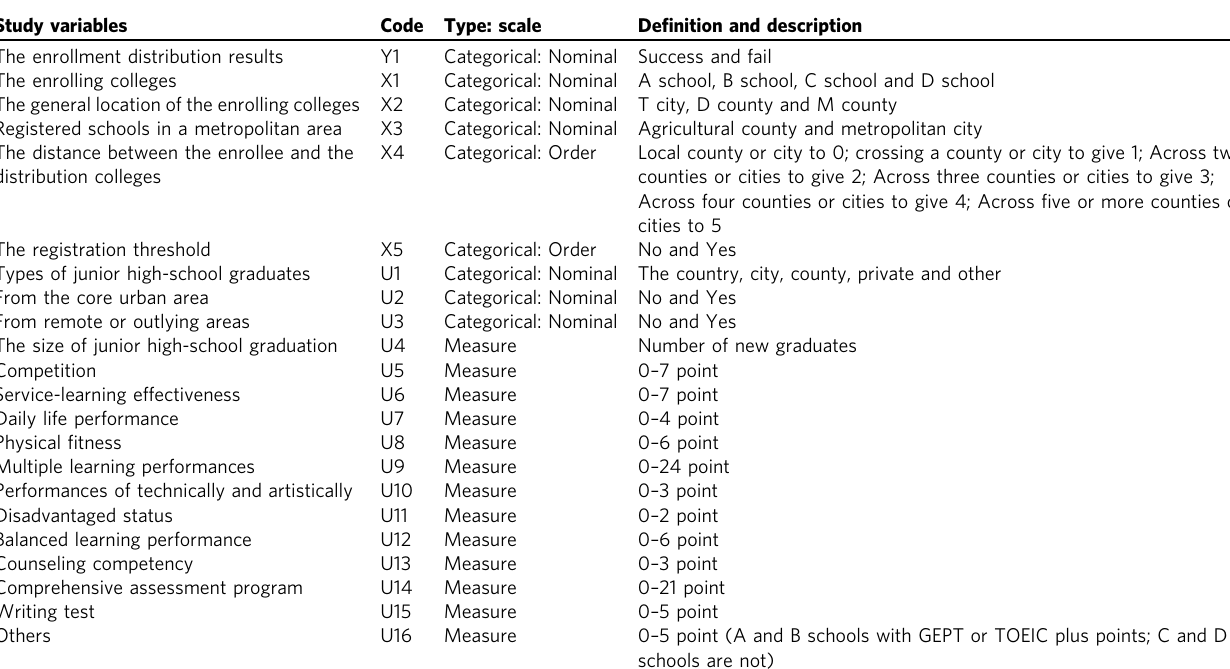
Table 2 The de fi nition and description of the study